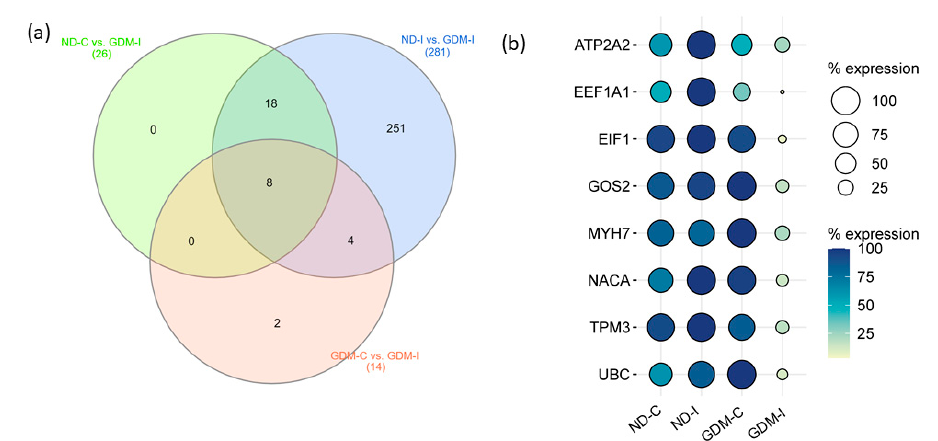
Figure 6. Prognostic values of potential muscle biomarker genes for gestational diabetic-induced myopathy. ( a ) Venn diagram showing the intersection of eight genes expressed differentially in the GDM-I group (GDM-I): ATP2A2, EEF1A1, EIF1, G0S2, MYH7, NACA, TPM3, and UBC. ( b ) Balloon plot showing the expression profiles of these genes, using the count/percentage of RNA-seq. ND-C: non-GDM continent women (no PSUI); ND-I: non-GDM incontinent women (with PSUI); GDM-C: GDM continent women (no PSUI); GDM-I: GDM incontinent women (with PSUI) . Table 2. Classification (Gene Ontology) of potential muscle biomarker genes for gestational dia- betic-induced myopathy (GDiM).